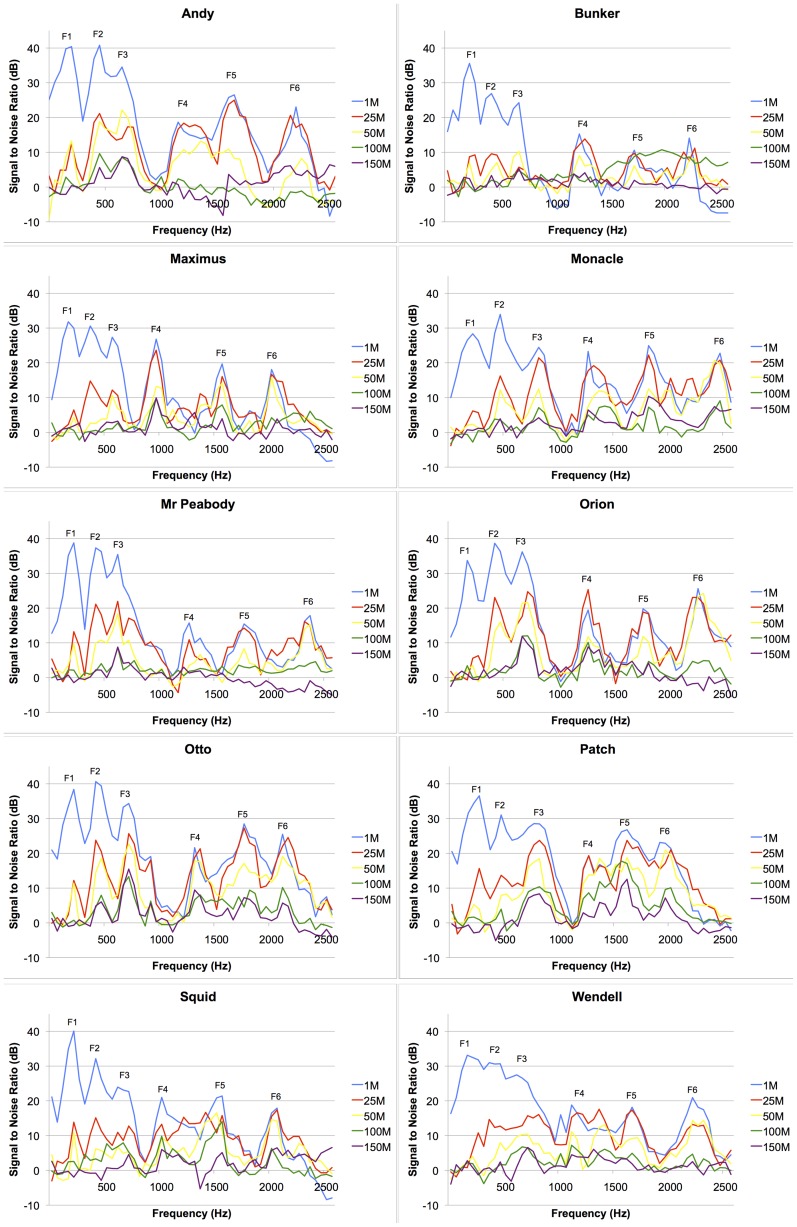
SNR plots.The plots illustrate how the frequency amplitudes of bellow inhalation sections from 10 male koalas attenuate over distance. Missing values indicate that the call was not detectable at the re-recording distance.